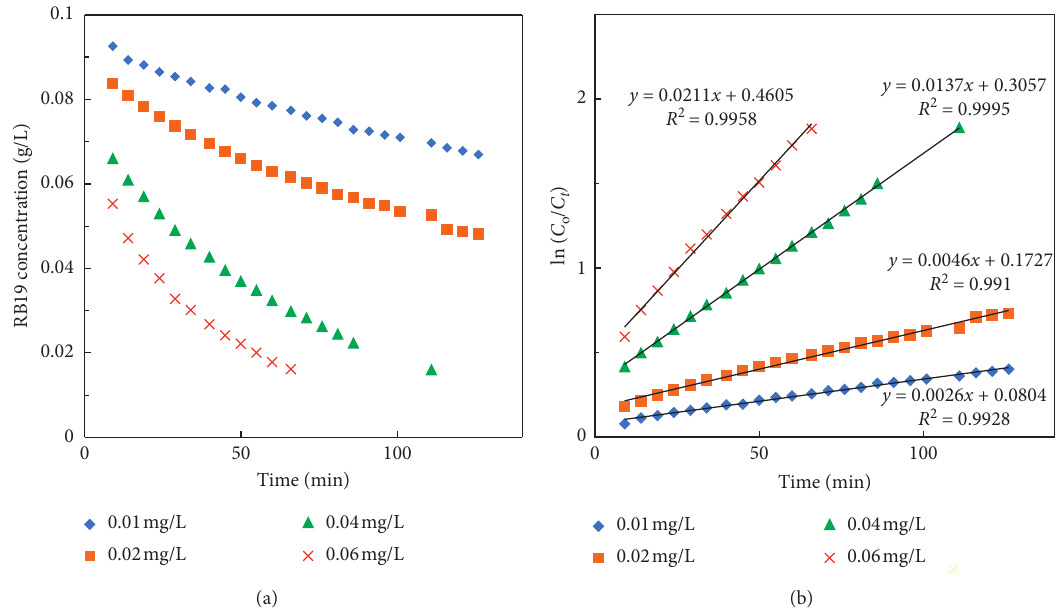
) vs. time at different Co 2+ concentrations and 10mM HCO − t